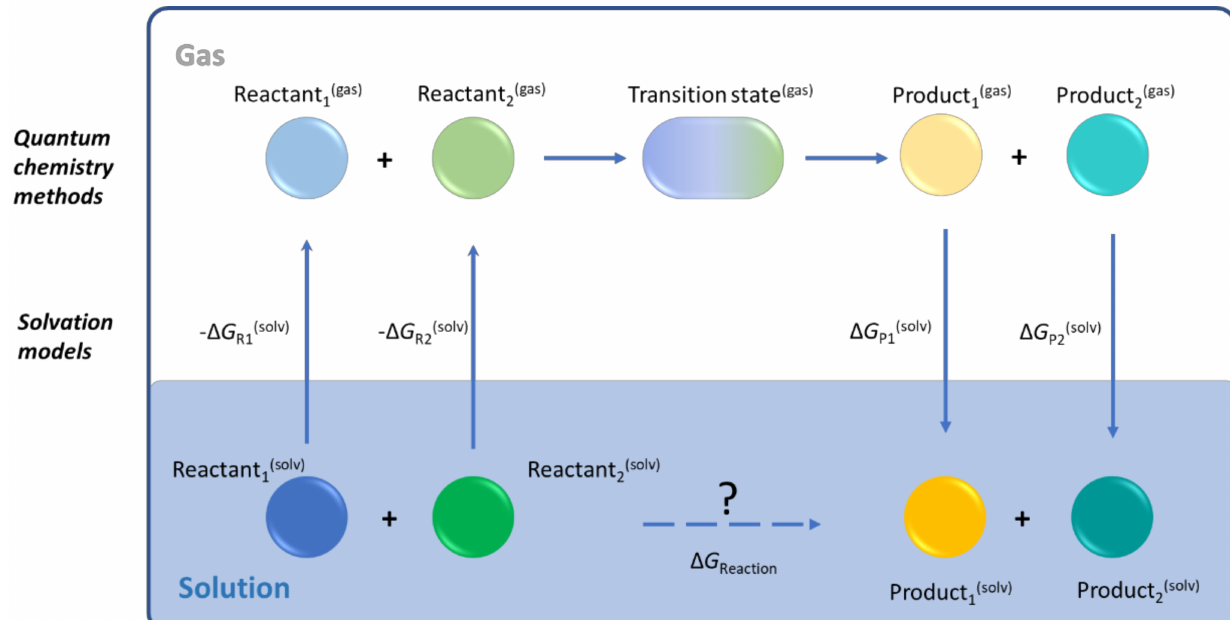
Figure 3. Thermodynamic cycle used to go from gas phase to condensed phase